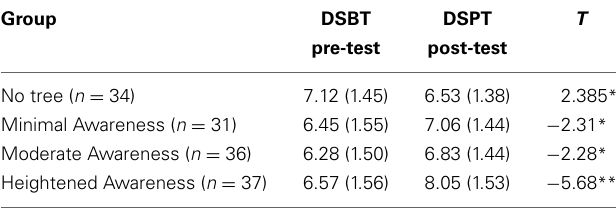
Table 1 | Mean directed attention score before and after